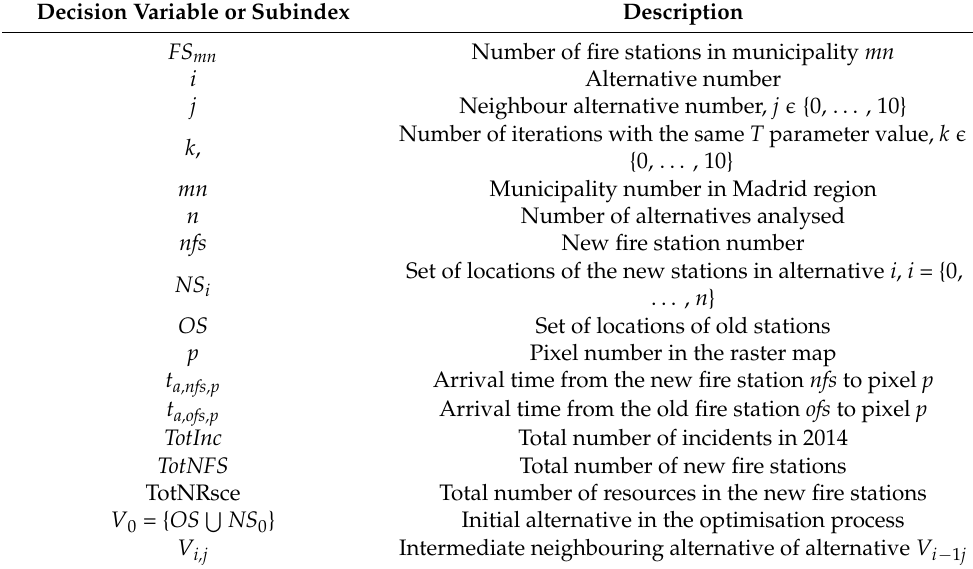
Table A1. Table of decision variables and